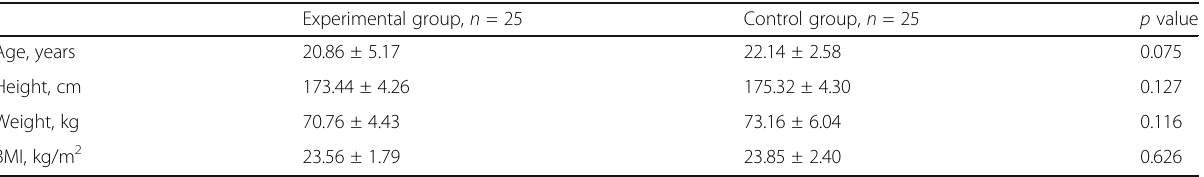
Table 1 Demographic data of participants